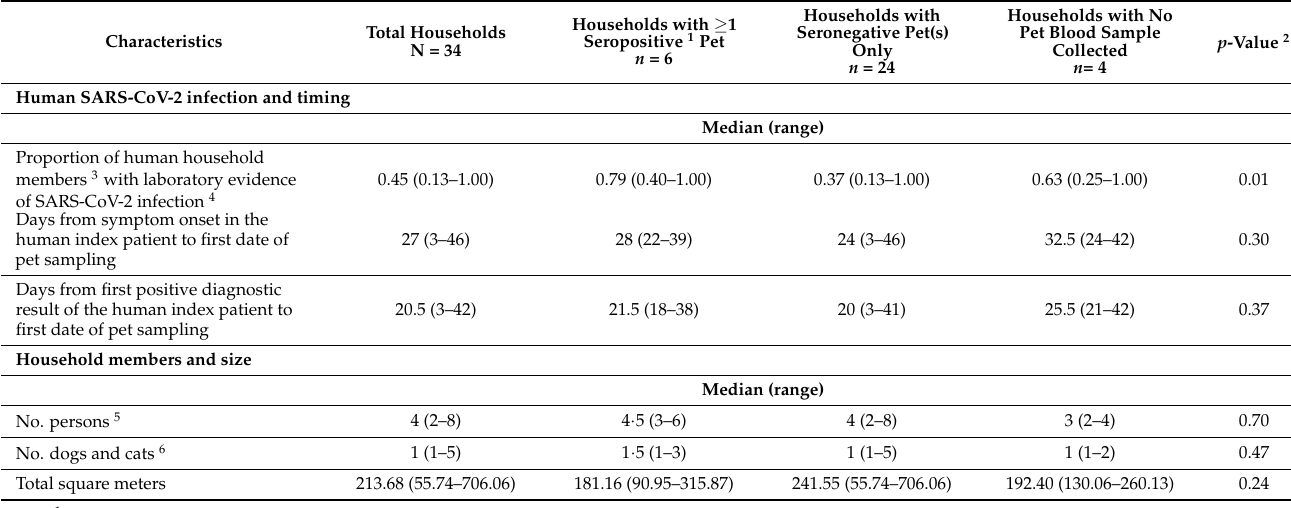
Table 2. Characteristics of humans with SARS-CoV-2 infection, household members, and timing of human illness